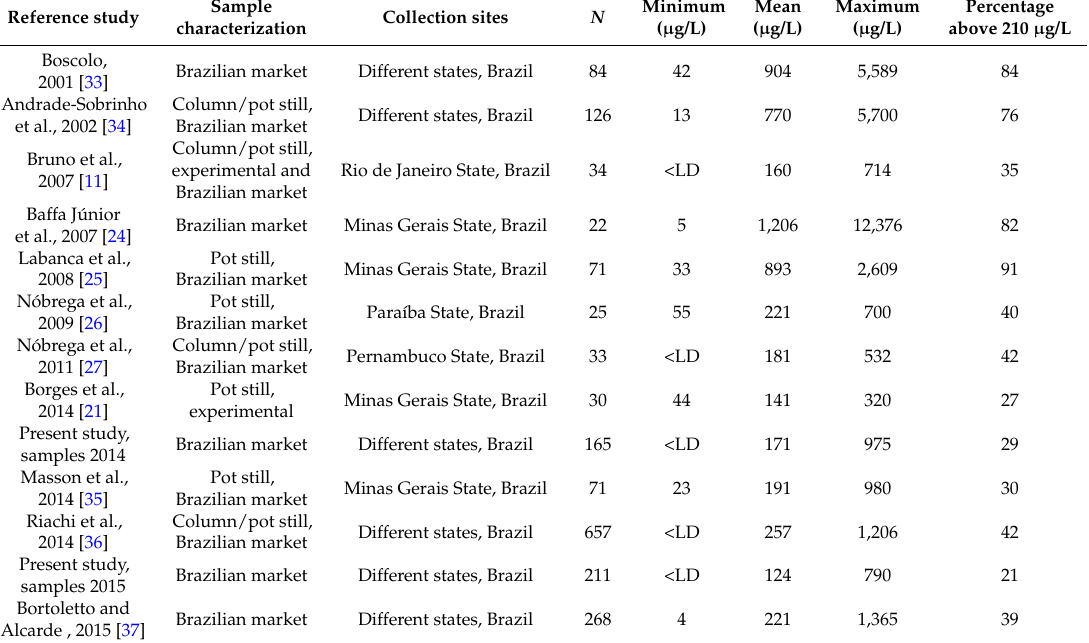
Table 4. Literature data on assessment of ethyl carbamate contamination in cachaça indicating the evolution of the percentage of samples not in compliance with Brazilian law over the years. LD: limit of